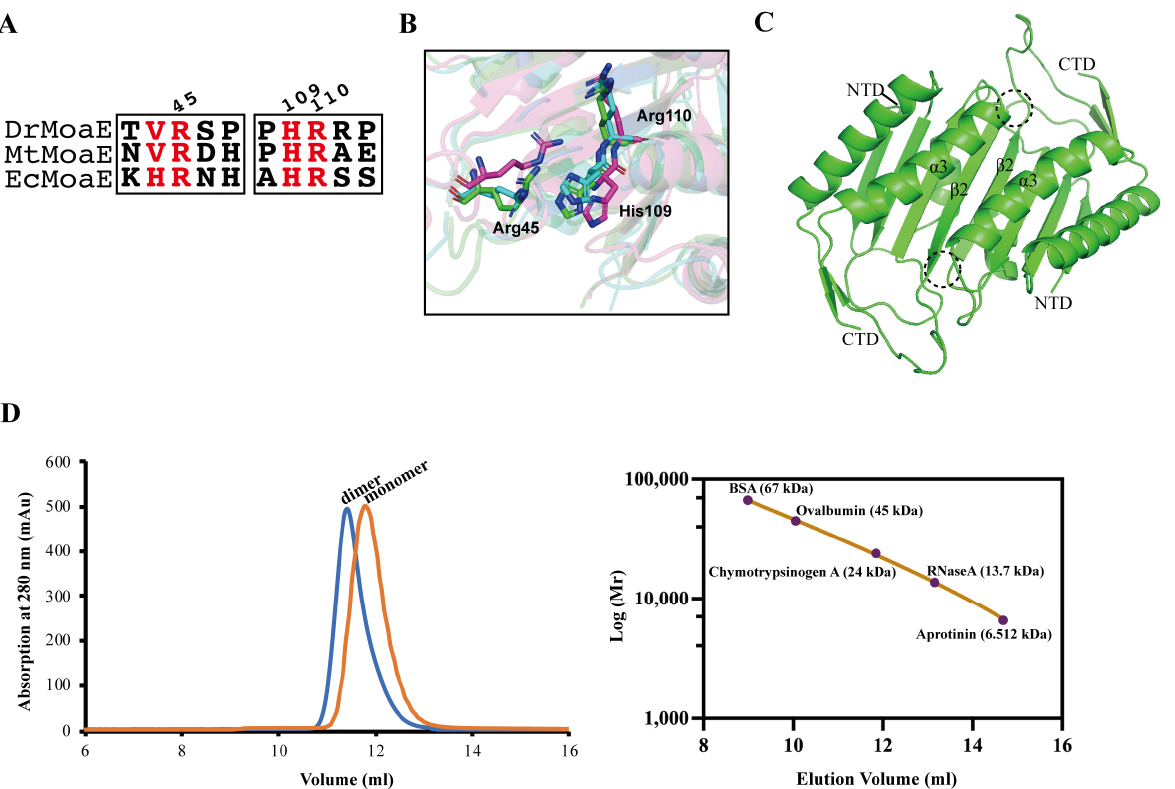
Figure 2. Roles of key amino acid residues in DrMoaE. ( A ) Sequence alignment of DrMoaE, MtMoaE, and EcMoaE. ( B ) Structure alignment of His109, Arg110, and Arg45 of DrMoaE with the corresponding sites of EcMoaE and MtMoaE. D. radiodurans (green), E. coli (purple), M. tuberculosis (blue). ( C ) The structure of DrMoaE; the dotted box represents the anion binding pocket. ( D ) Gel filtration profiles of DrMoaE and DrMoaER110A. Blue represents DrMoaE and orange represents DrMoaER110A. The protein standard curve was generated using a mixture of aprotinin (6.512 kDa), RNaseA (13.7 kDa), chymotrypsinogen A (24 kDa), ovalbumin (45 kDa), and BSA (67 kDa).